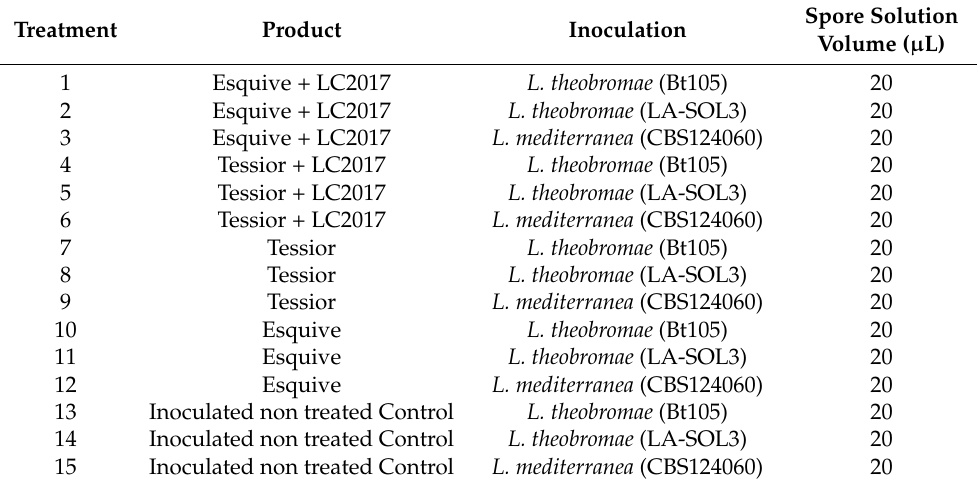
Table 5. Treatment plan designed to assess the efficacy of three products against pruning wound infection by Lasiodiplodia theobromae and Lasiodiplodia mediterranea . Combinations of products used and inoculations spore solution